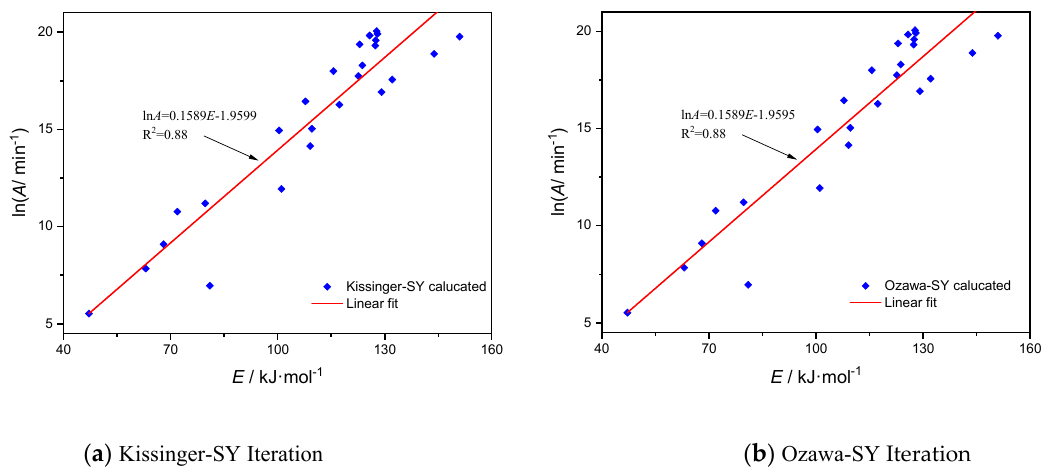
Figure 5. Linear correlation between the activation energy of Al-lignin and the preinhetial factor based on two iterative methods.